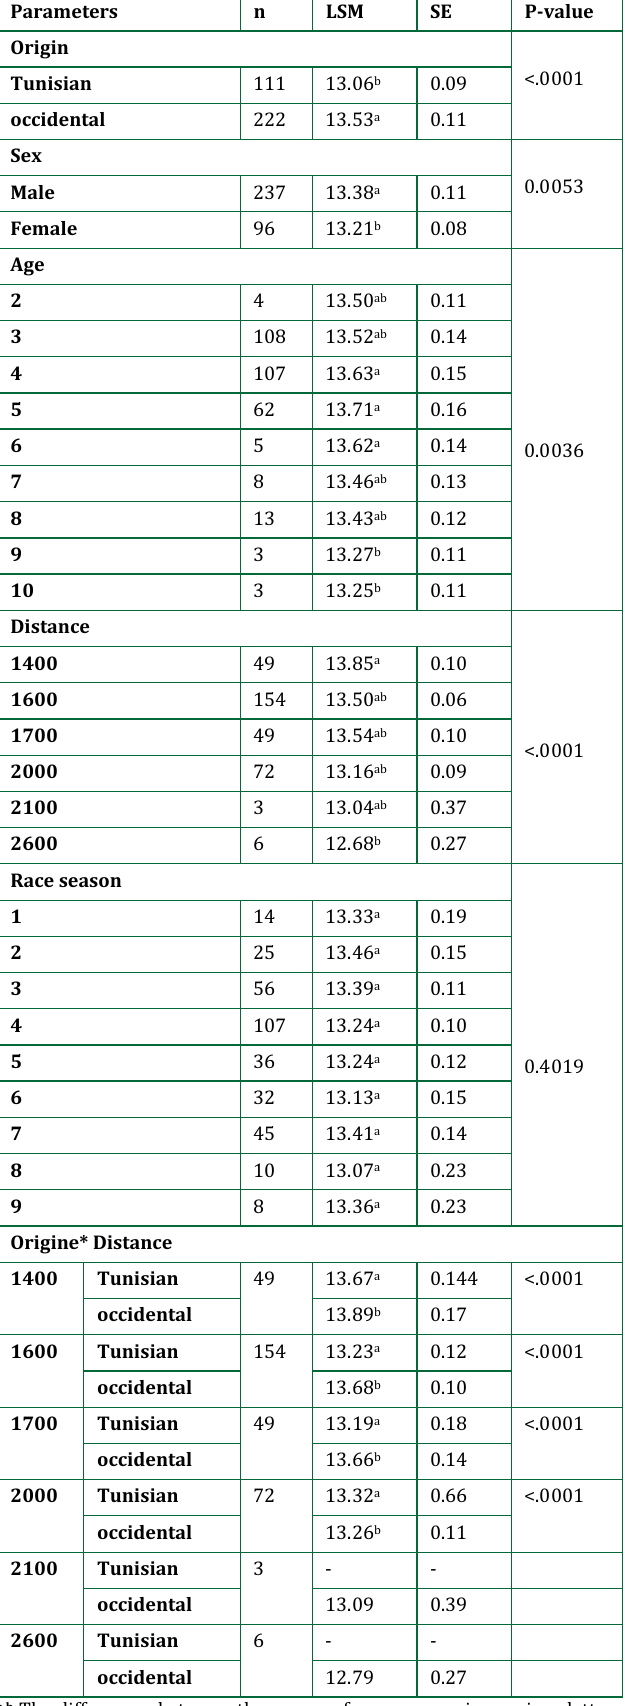
Table 3: Effects of the studied parameters on the speed of